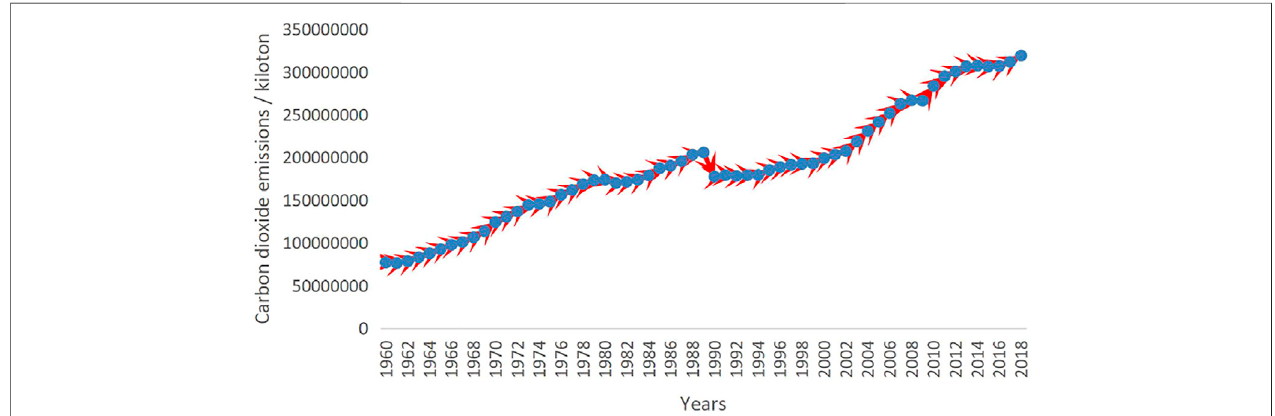
FIGURE 1 | Carbon dioxide concentration in the Earth ’ s atmosphere (1960 – 2018). Data Source: The data source was obtained from the Carbon Dioxide InformationAnalysisCenter,DepartmentofEnvironmentalSciences,OakRidgeNationalLaboratory,Tennessee2022,https://data.worldbank.org.cn/indicator/en.atm. co2e.kt.SourceNote:Carbon dioxideemissions areemissionsfromthecombustion offossilfuelsandcement production. Theyincludecarbon dioxideproducedwhen consuming solid, liquid, and gaseous fuels and burning natural gas.